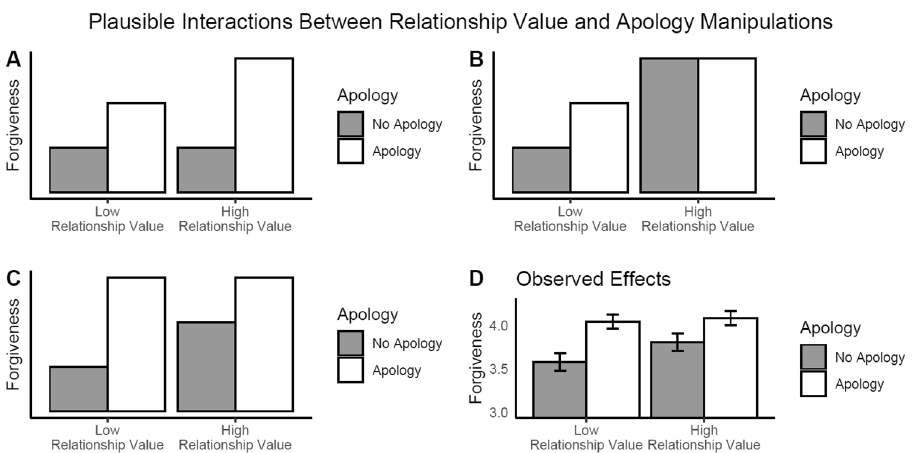
Figure 1. Three plausible interactions between levels of relationship value and apology manipulations ( A – C ), as well as the observed interaction ( D ). In ( A ), the effects of the relationship value and apology manipulations are greater than the sum of their isolated effects. In ( B ), manipulation of relationship value provides the strongest forgiveness-relevant information, rendering the apologies ineffective in the high relationship value condition. In ( C ), apologies provide the strongest forgiveness-relevant information, rendering the relationship value manipulation ineffective in the apology condition. To produce the figure in ( D ), we computed a simple composite score from the TRIM-NCO along with error bars representing 95% confidence intervals; the pattern we observe in our data is the most similar to ( C